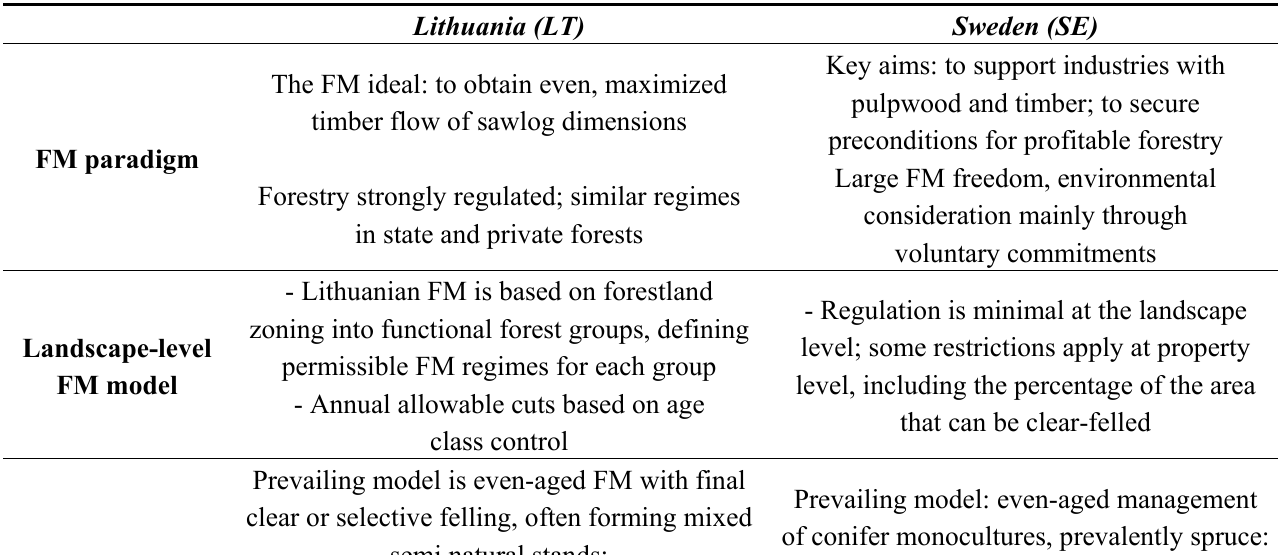
Table 2. Current forest management (FM) models in Lithuania and Sweden. MARA, minimum allowable rotation